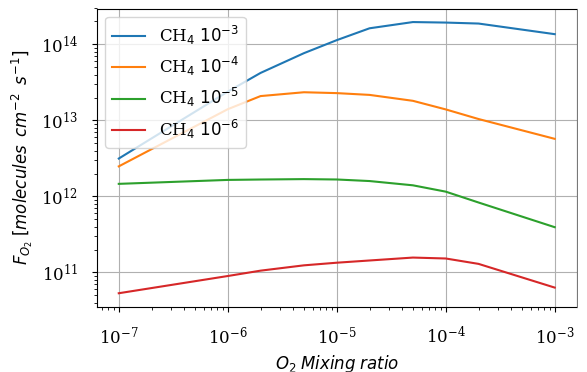
) as a function of surface 2